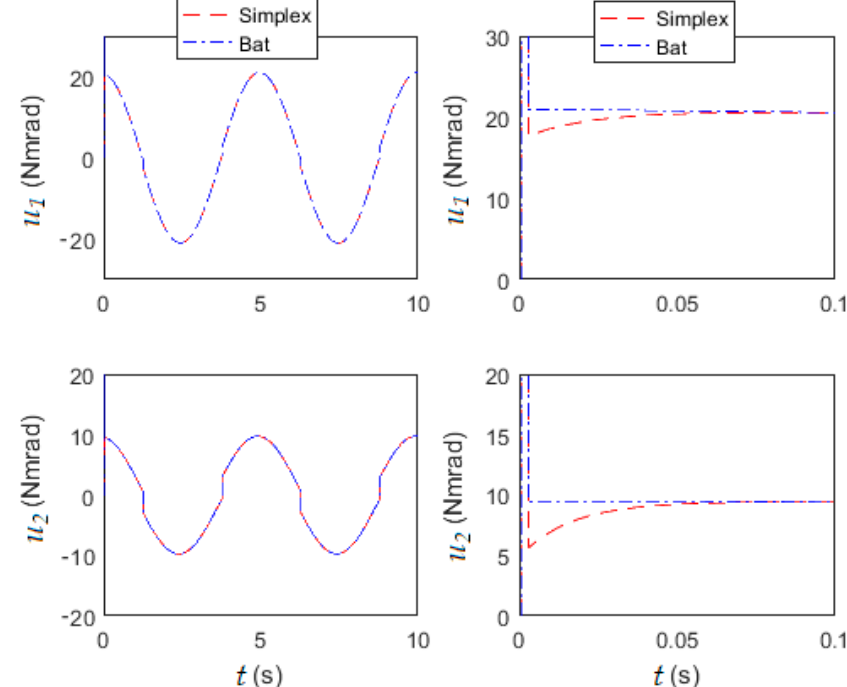
Figure 5. Evolution of the forces.